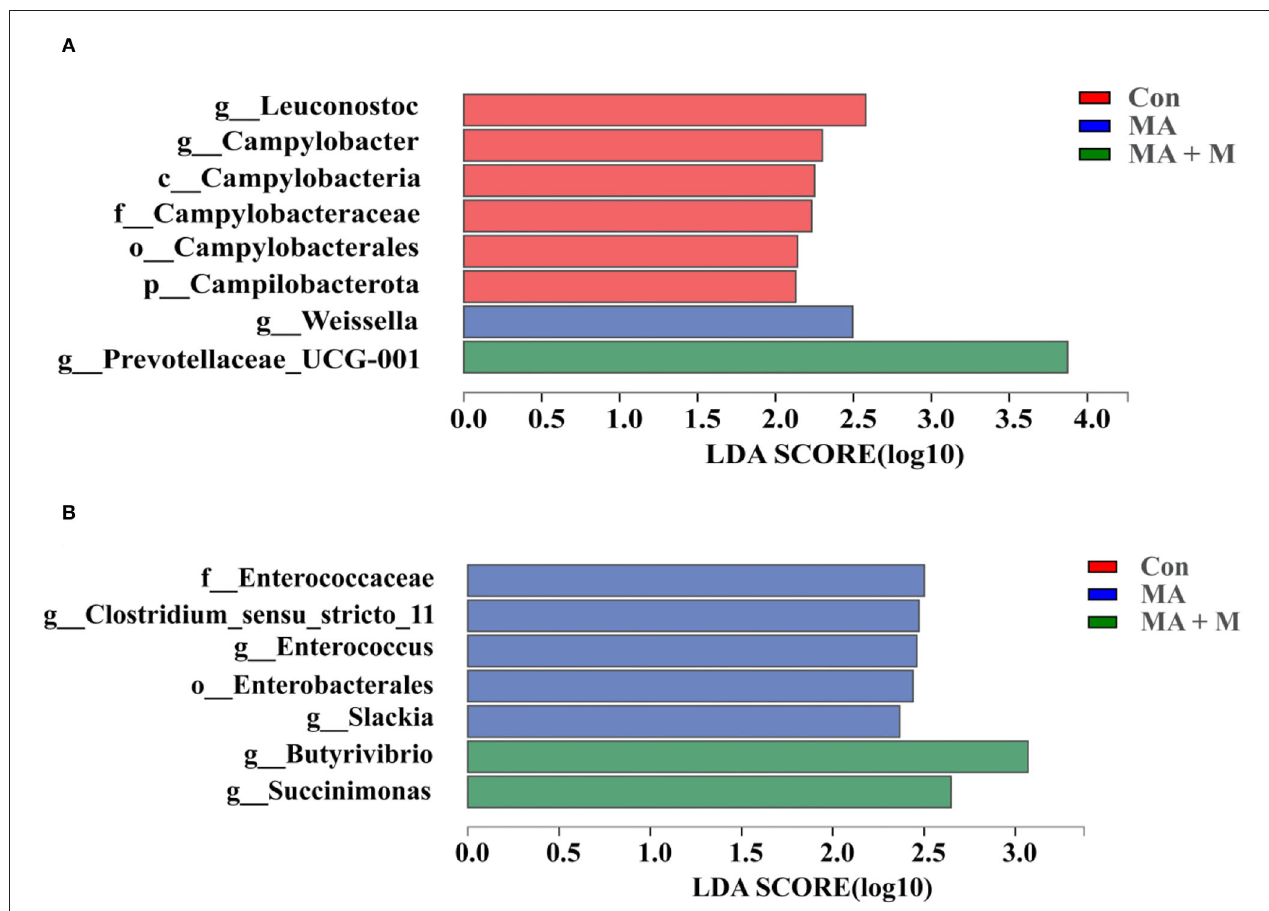
FIGURE 8 | Indicator bacteria with LDA scores of 2 or greater in bacterial communities associated with different pretreatments at 0.5h (A) and 4h (B) . Different-colored regions represent different constituents (red, Con; blue, MA; green, MA + M). Con, no additive, control; MA, added microecological agents; MA + M, a combination of microecological agents and